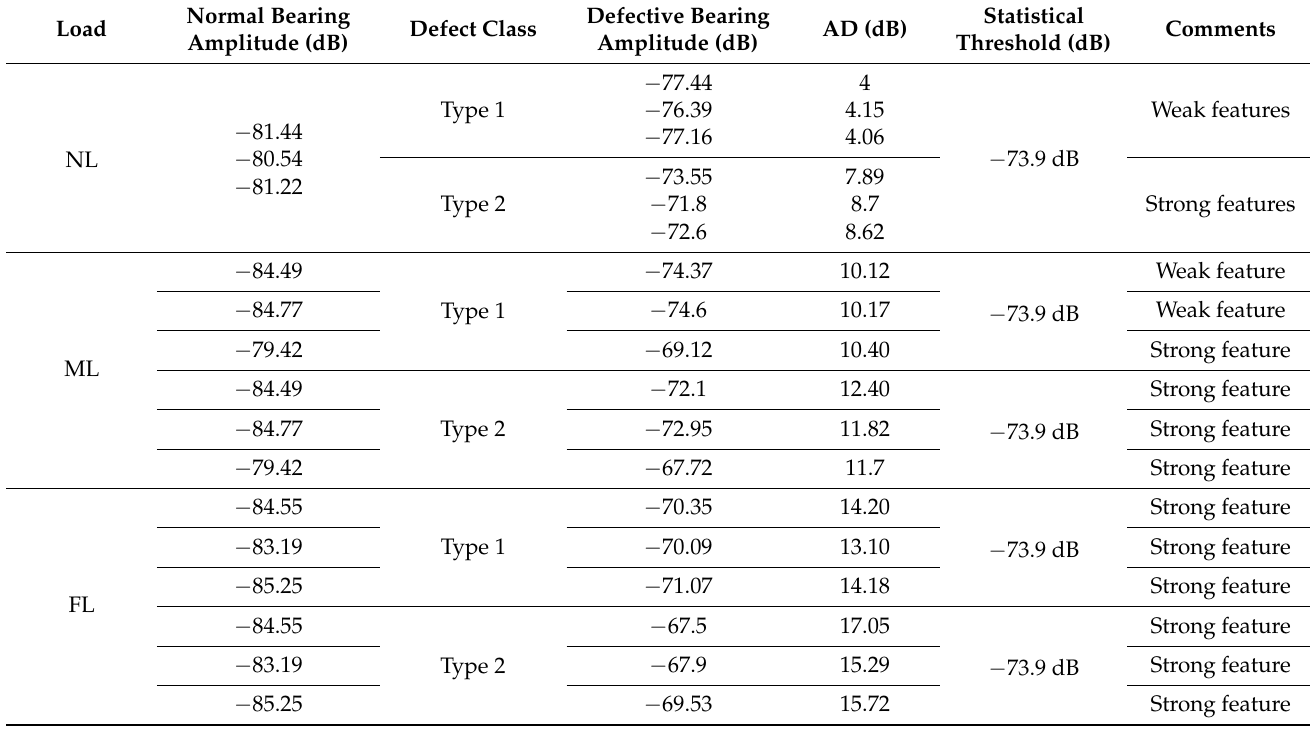
Figure 7. The ML plots for the defective bearing: ( a ) normal bearing, ( b ) type 1 defect and ( c ) type 2 defect. Table 2. The identification of strong features and weak features through the